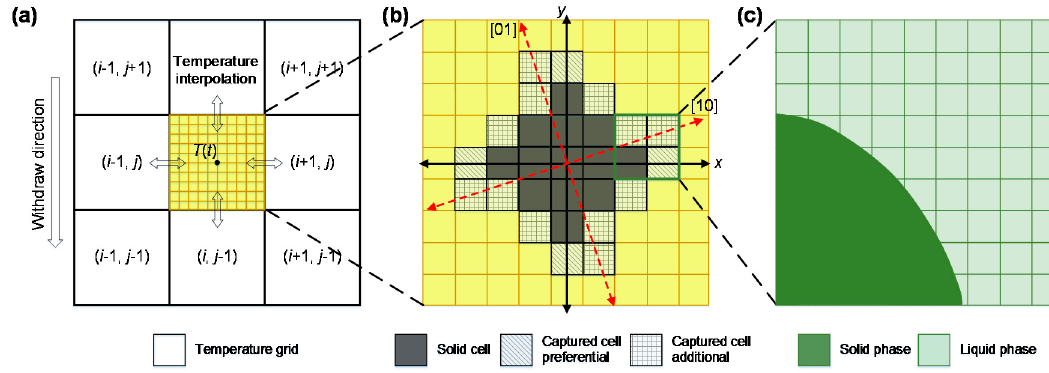
Figure 2. Schematic of coupling calculation between the macro and micro scales: ( a ) temperature interpolation from coarse macro grids to fine CA cells; ( b ) modified CA-based cell capture algorithm for grain growth simulation; and ( c ) the smallest phase-field grids for micro scale dendrite growth simulation.